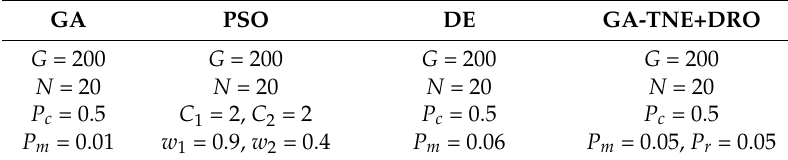
Table 3. Parameter setting for GA, PSO, DE, and GA-TNE+DRO.